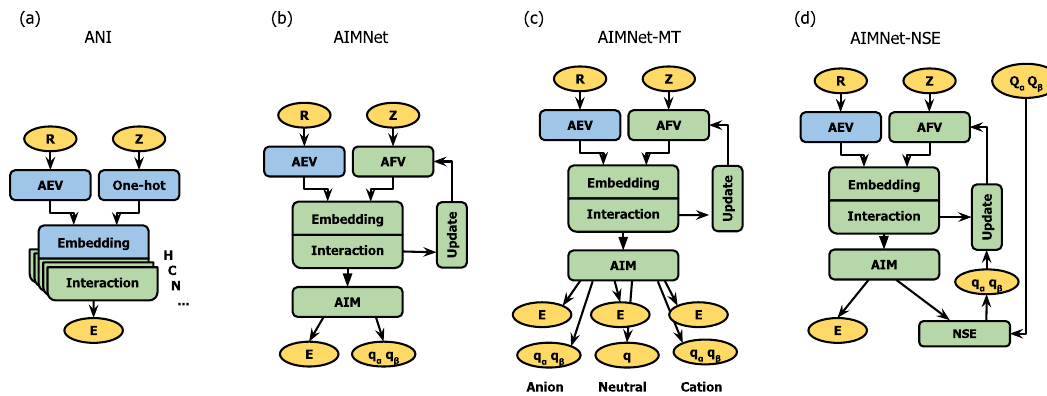
Fig. 1 Neural network architectures explored in this work. Models from literature: a ANI 13 , b AIMNet 8 . Here each model is separately trained for neutral species, cations, and ions. Models introduced in this work: c AIMNet-MT: a multitask model jointly trained on all data which concurrently predicts energies and charges for neutral species as well as cations and ions; and d AIMNet-NSE, a Neural Charge Equilibration model which is capable to re-distribute spin- polarized atomic charges according to a given molecular spin charges and predicts energy for the speci fi ed (arbitrary) spin state of the molecule. The yellow blocks show input data (coordinates R , atomic numbers Z , and total molecular spin charge Q ) and output quantities (energies E and spin-polarized charges q ). The green blocks denote trainable modules, and the blue blocks are fi